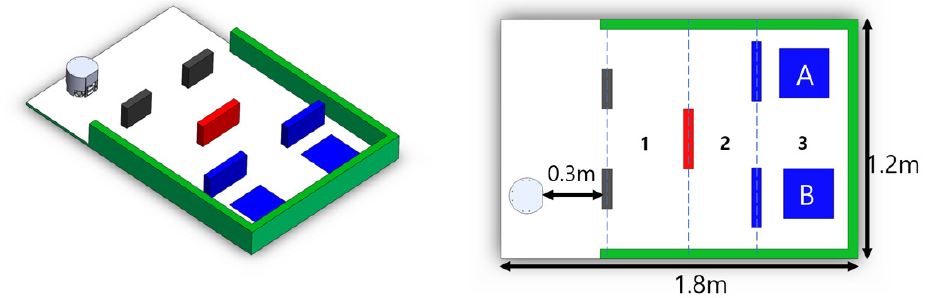
Figure 8. Driving field for the project-based challenge in the mechatronics class.